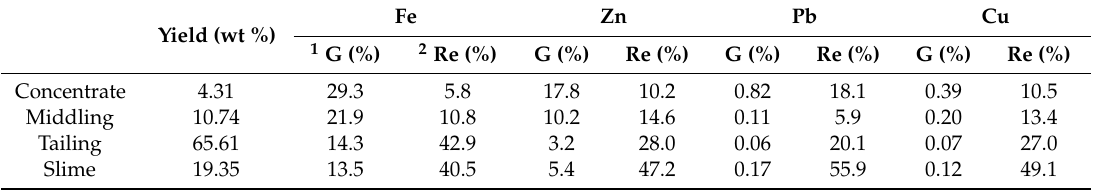
Table 4. Results of gravity separation using a shaking table. (Angle of shaking table: 2.5 ◦ ;